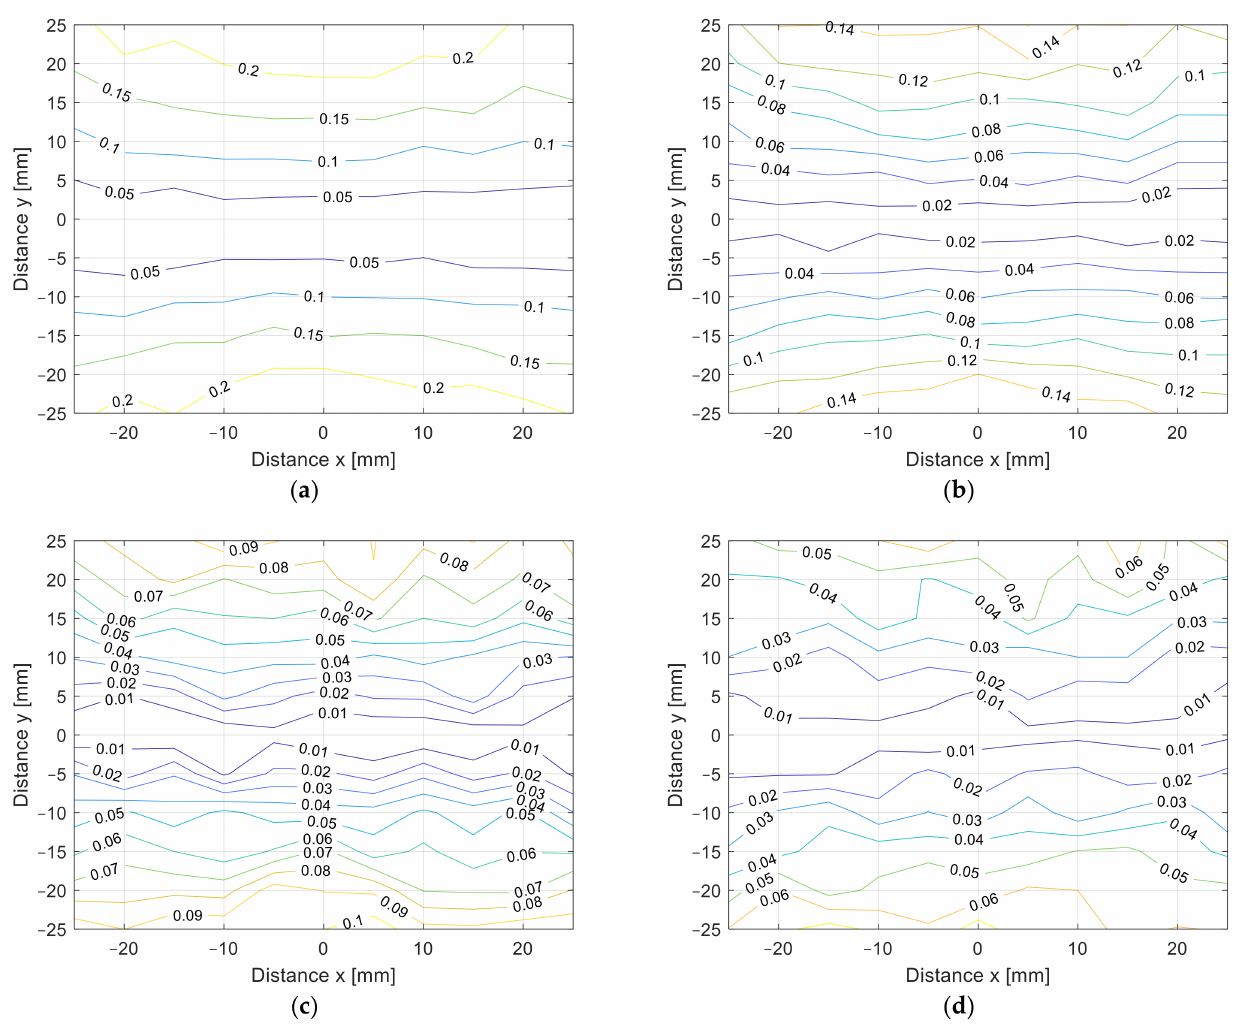
Figure 18. x - y coupling coefficient measurement between the DD coil and square coil (contour plot). ( a ) At z = 10 mm, ( b ) At z = 15 mm, ( c ) At z = 20 mm, ( d ) z = 25